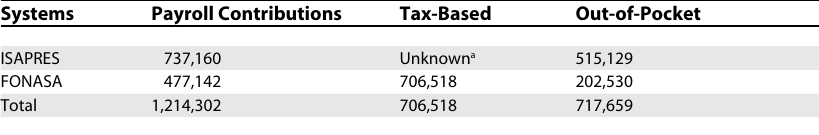
Table 1. Sources of Health Expenditure in Chile, 2003 (Millions of Chilean